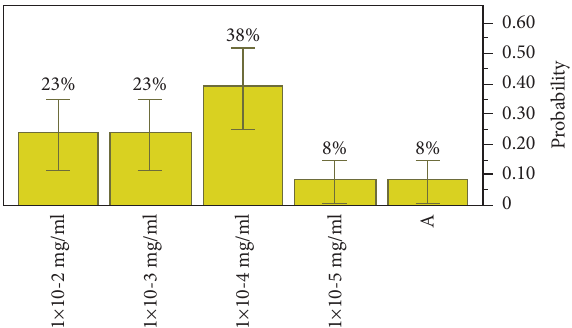
Figure 2: Distributions and test probabilities of extract B on target organisms.